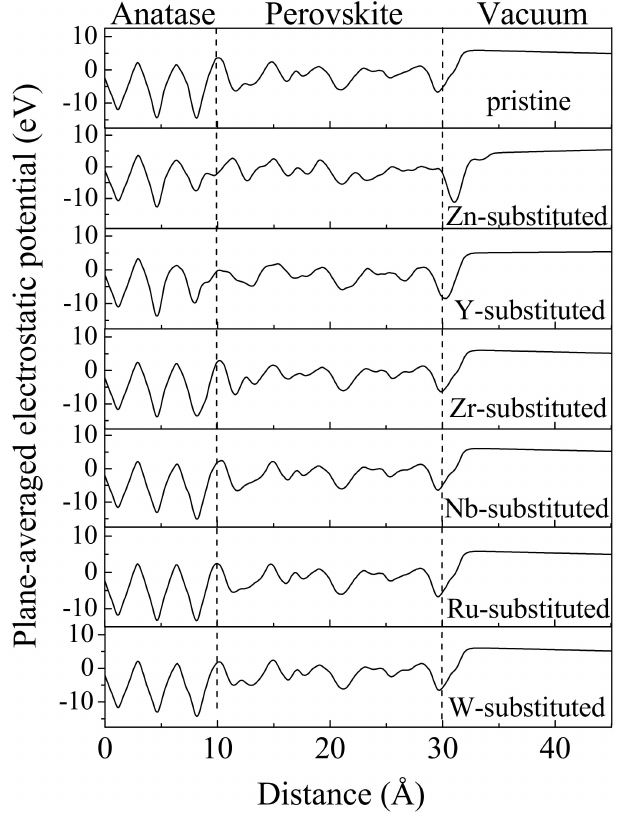
Figure 4. Planar averaged electrostatic potential across the optimized transition metal-substituted CH 3 NH 3 PbI 3 / TiO 2